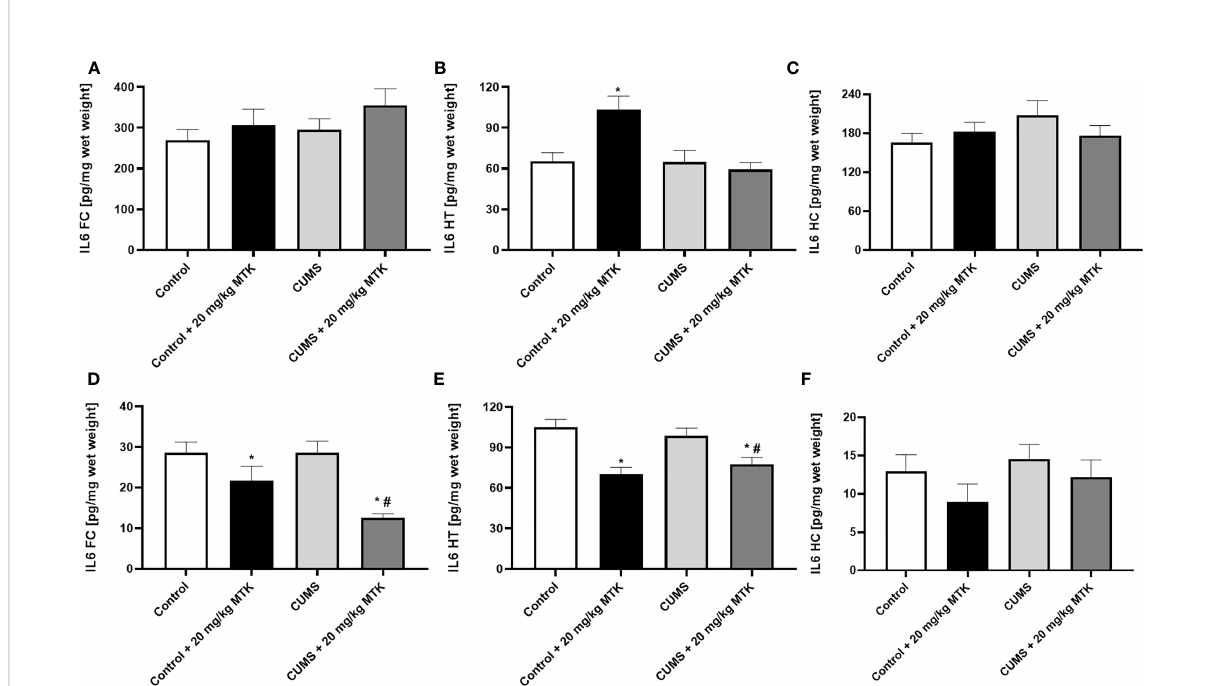
FIGURE 8 Effects of MTK on brain IL-6 levels. Male (A-C) and female (D-F) rats were exposed to CUMS or control conditions for four weeks and then, while remaining under these conditions, were treated for two weeks with MTK 20 mg/kg or vehicle. IL-6 levels in FC (A, D) , HT (B, E) and HC (C, F) were determined by ELISA. Each column is the mean ± SEM of 12 to 18 rats per group. Using one-way ANOVA (with Benjamini – Hochberg False Discovery Rate), followed by Student ’ s t-test for speci fi c group comparisons: *p < 0.05 vs. Control + DMSO; #p < 0.05 vs. CUMS +